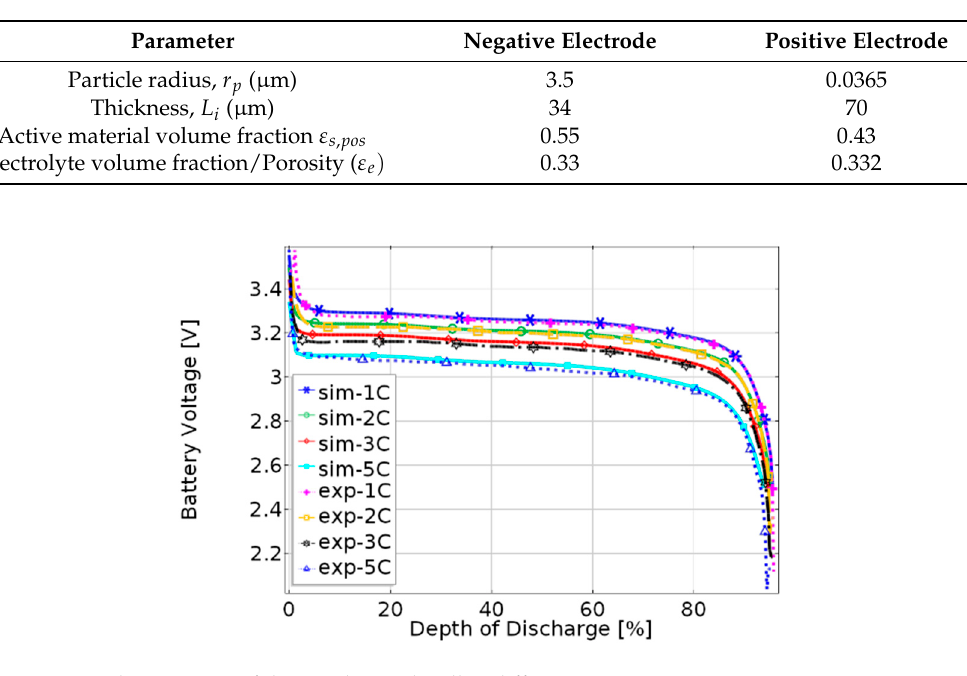
Figure 2. Discharge curve of the 10 Ah pouch cell at different C-rates, at room temperature, T amb = 25 (cid:1320) with natural cooling condition.